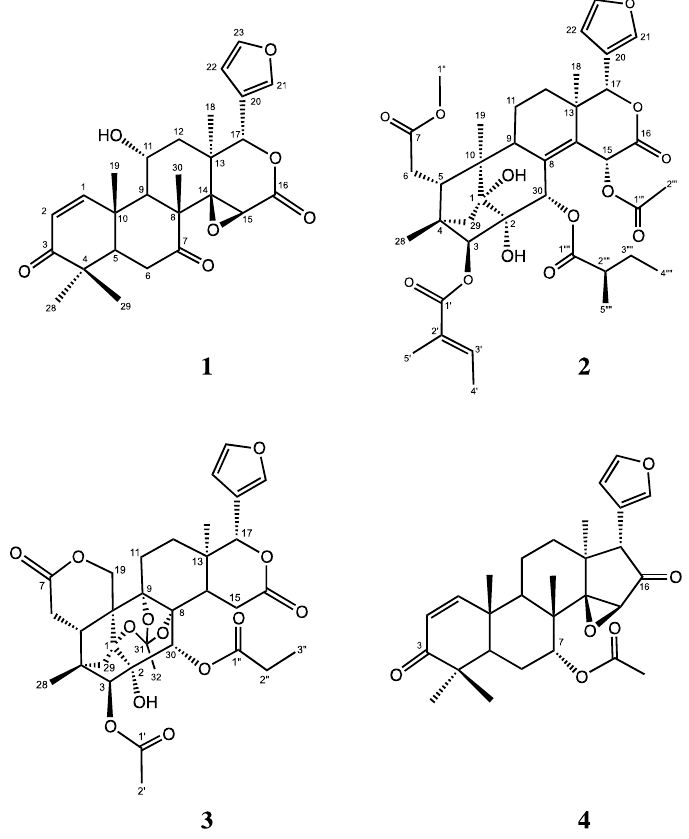
Figure 1. Chemical structures for compounds 1 – 4 .